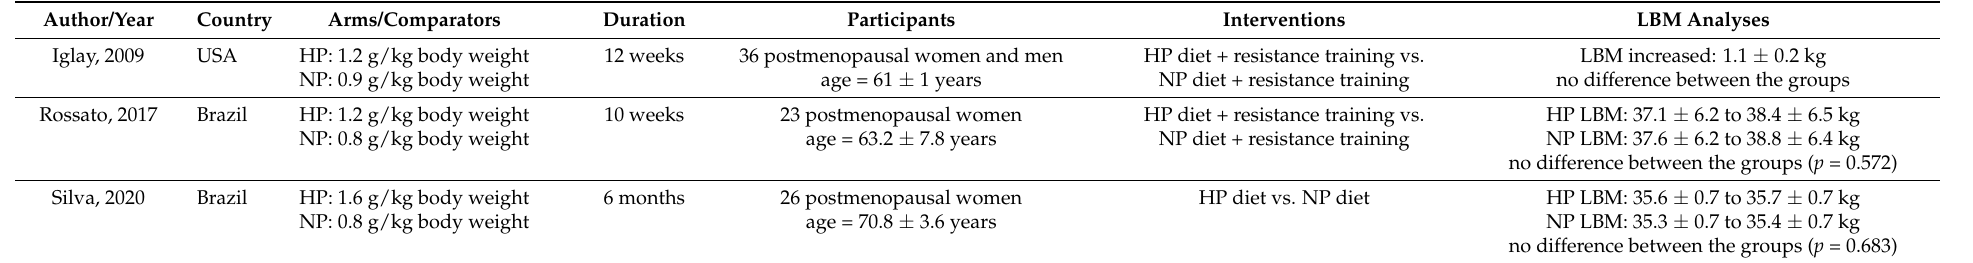
Table 1. Randomized controlled trials about the effect of high protein diets on LBM in postmenopausal women.